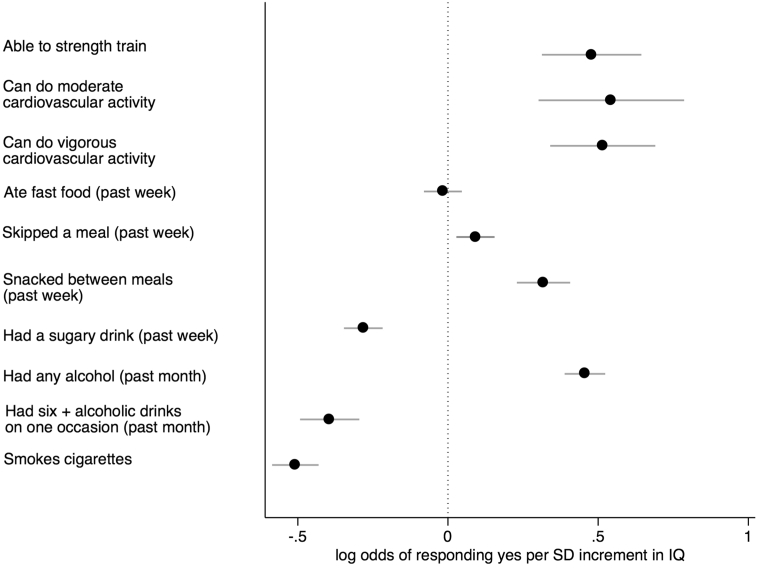
Log odds of responding yes to each health behaviour question, in middle age, per SD increment in intelligence in youth, adjusted for age at the time of interview, sex, and ethnicity.